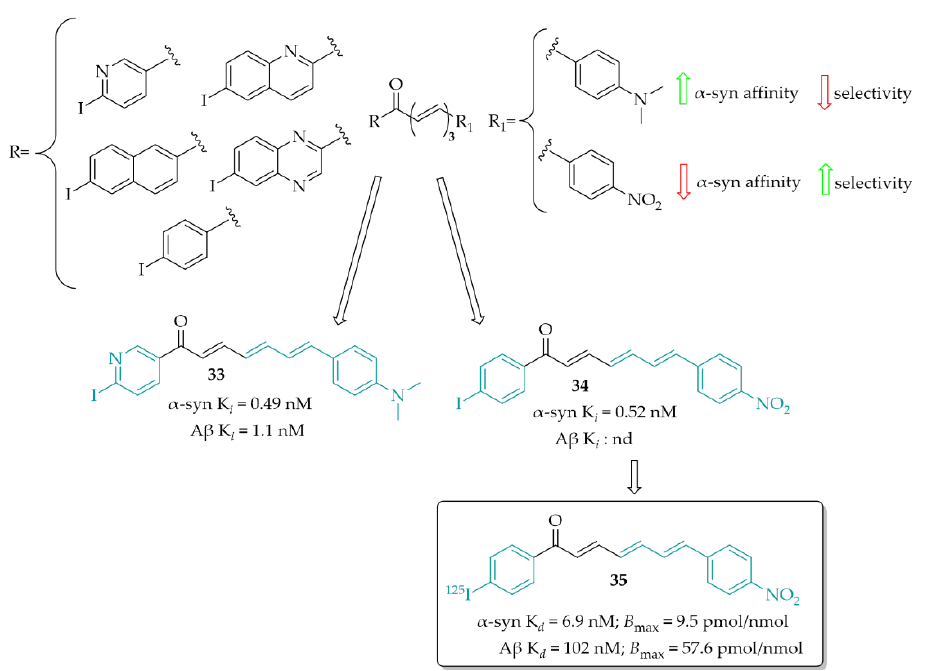
Figure 25. Chalcones as α -syn imaging probes and the most active componuds in this series; nd — not determined [55].